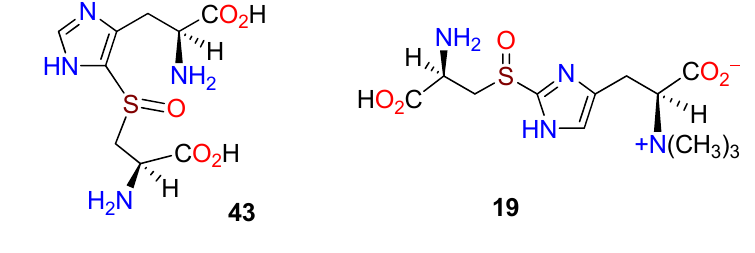
Figure 17. Structures of 43 and 19